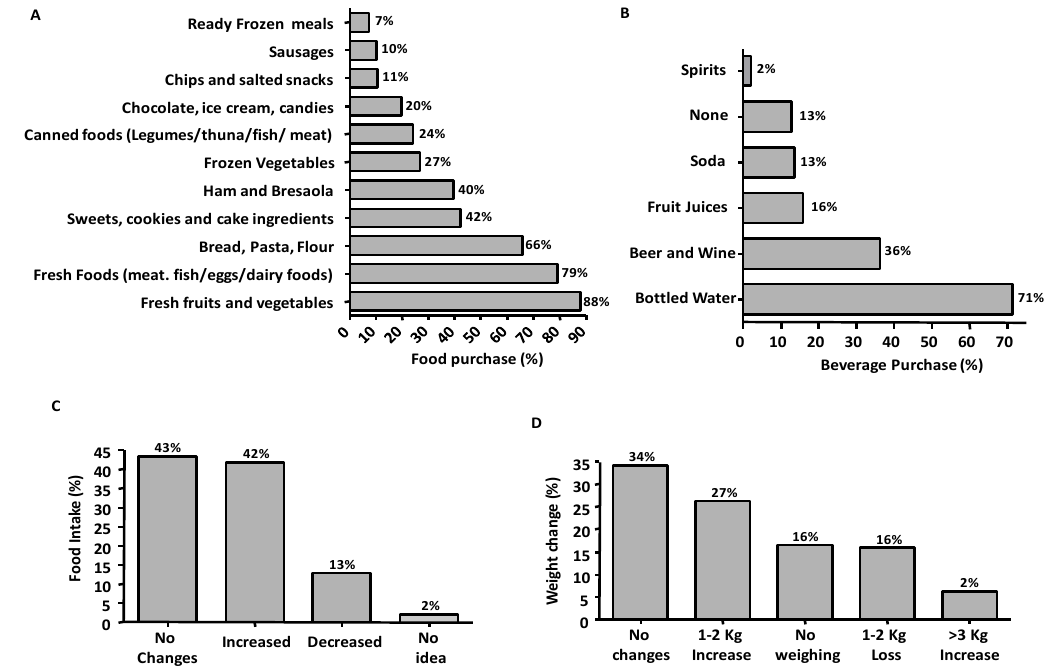
Figure 3. Frequencies of the more frequently chosen foods ( A ) and beverages ( B ) during lockdown. Changes in food intake ( C ) and weight ( D ) during lockdown.